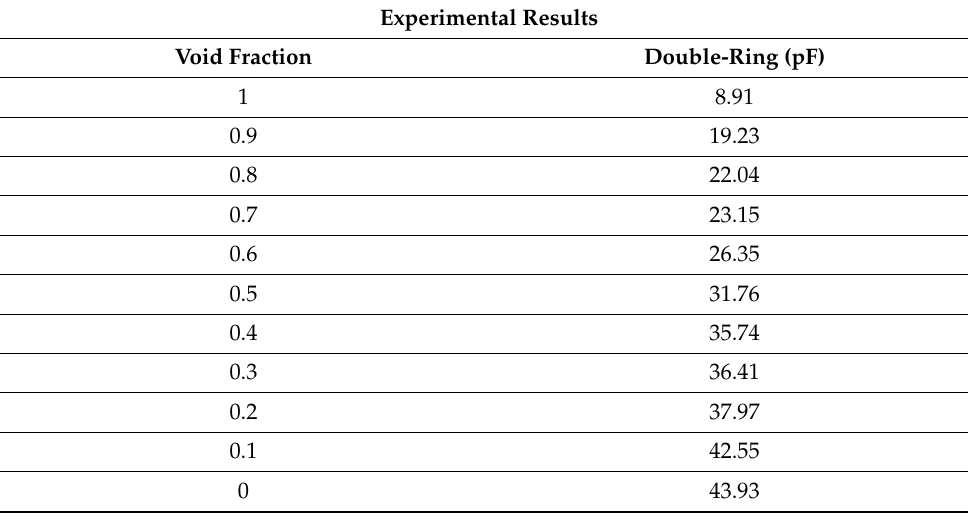
Table 1. Measured capacity values in different void fractions for double ring sensor.